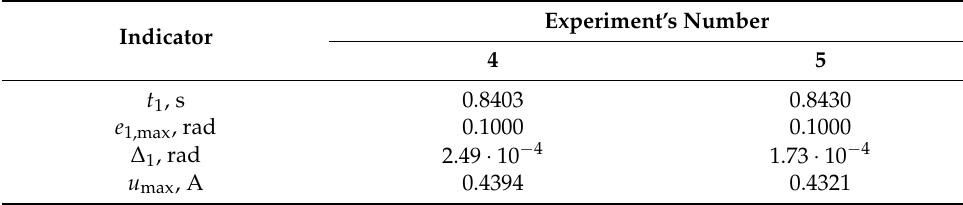
Table 3. Values of performance indicators of closed-loop